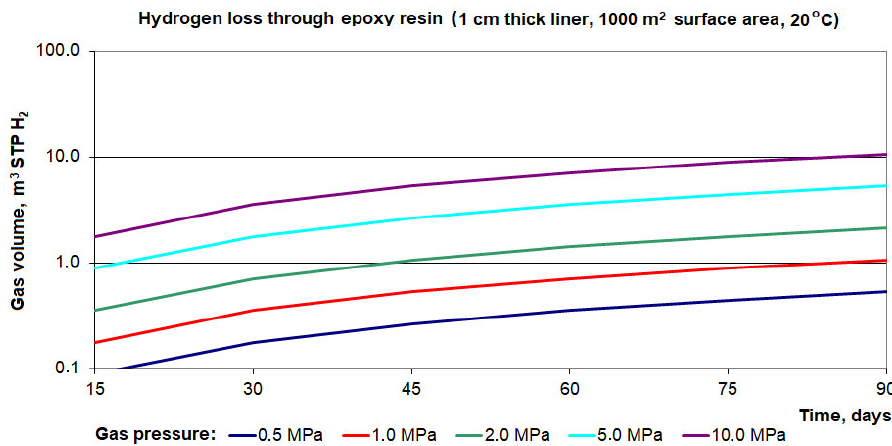
Figure 6. Calculated hydrogen leaks through epoxy resin in different gas pressure conditions (1 cm thick, 1000 m 2 surface area, 20 °C).